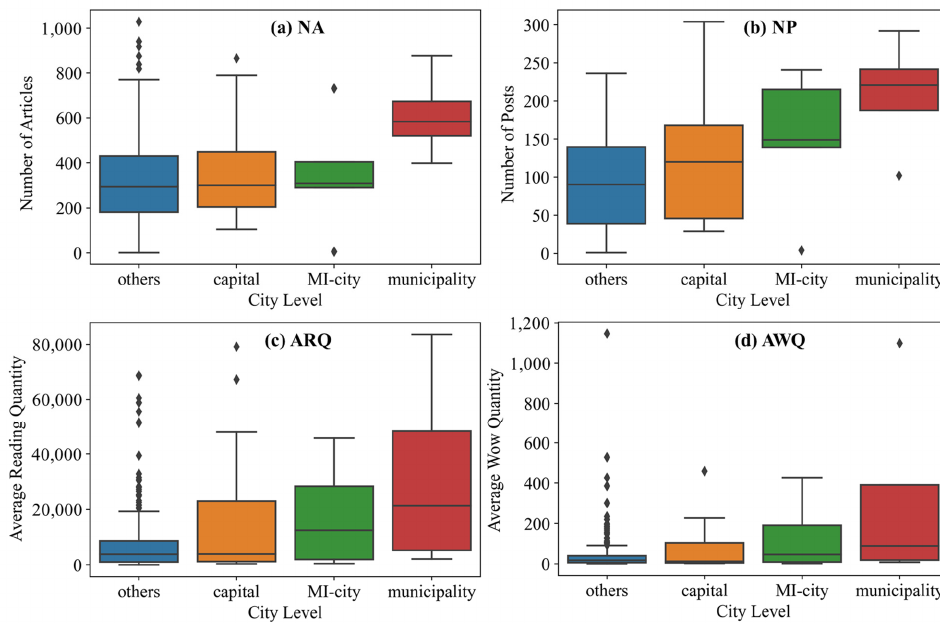
Figure 2. Differences in the emergency response and risk communication in different cities. Note: The comparison of ( a ) NA, ( b ) NP, ( c ) ARQ and ( d ) AWQ at different city levels.